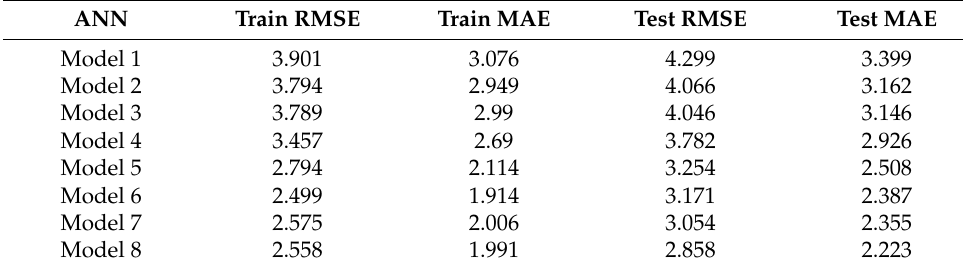
Table 8. Train and test RMSE and MAE for all ANN models.